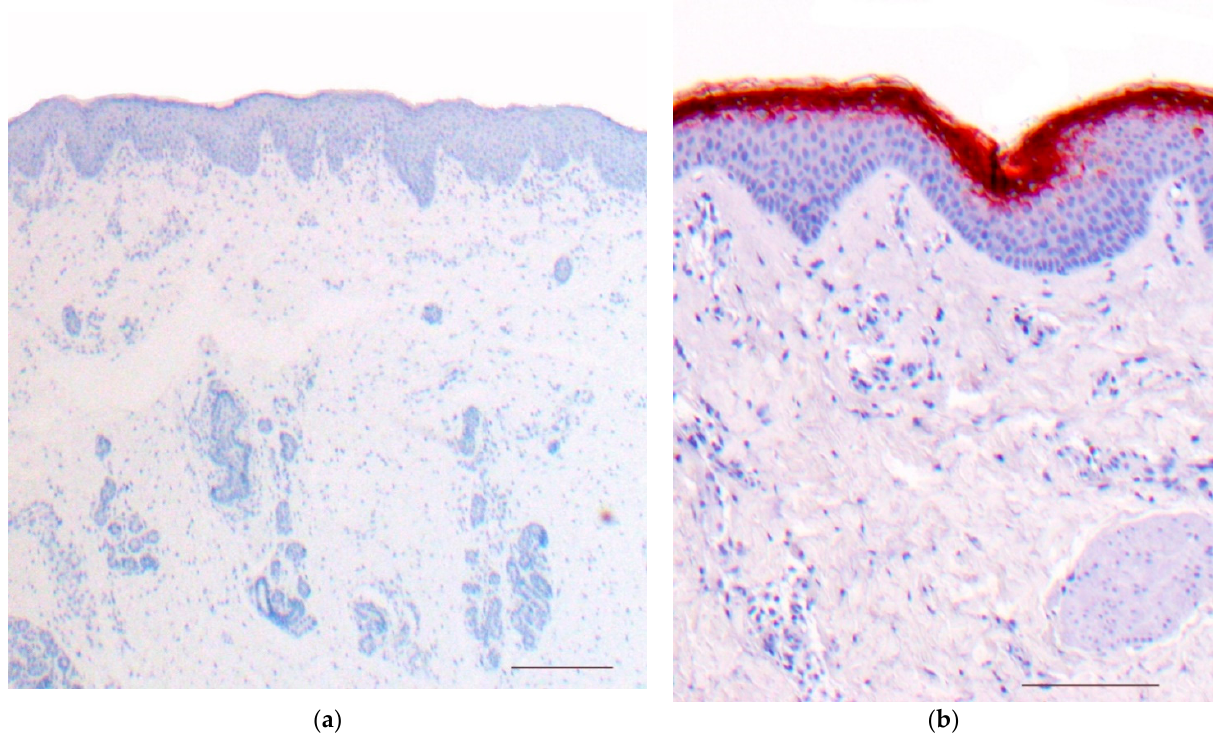
Figure 11. Netherton syndrome, immunohistochemistry, bar = 200 µm ( a , b ). Immunohistochemistry shows a lack of staining for LEKTI in the epidermis and hair follicles ( a ); regular expression of LEKTI in the upper layers of the epidermis of healthy skin, bar = 200 µm ( b ). Immunoperoxidase staining.